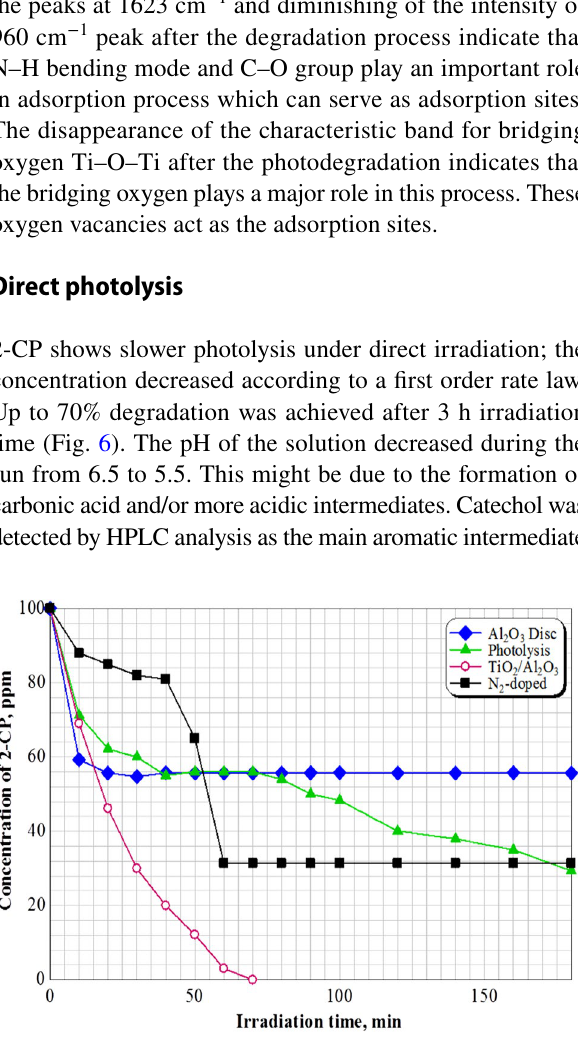
Fig. 6 Photolysis and photocatalytic degradation of 2-CP using: Al 2 O 3 disc, TiO 2 /Al 2 O 3 thin films and TiO 2 supported on glass sub-